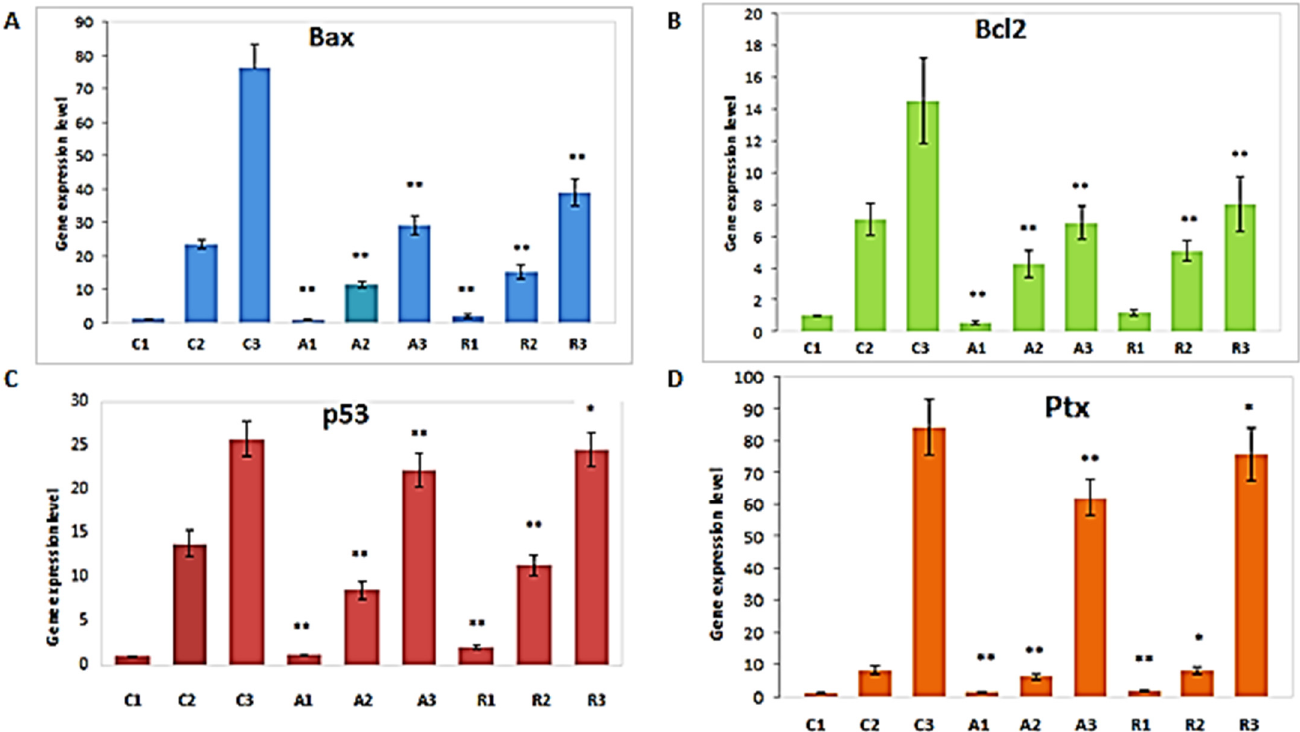
Figure 1. Bax ( A ), Bcl2 ( B ), p53 ( C ), and Ptx ( D ) gene expression levels in COC. Data represent the mean ± SD of the experiments, where * indicates a significant difference ( p < 0.05) and ** a high significant difference ( p < 0.01) of the experimental groups versus the control group, corresponding to their morphological class.